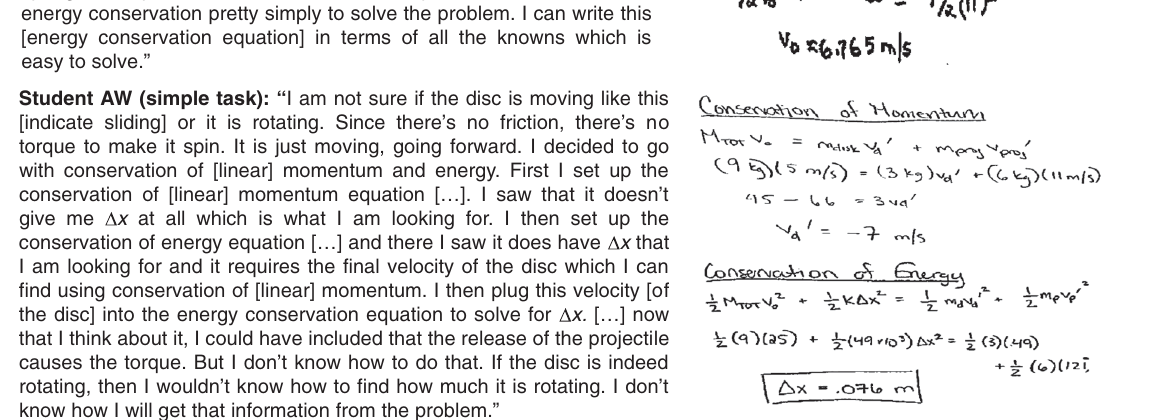
FIG. 9. Examples of interviews and written responses for the complex and simple simultaneous synthesis